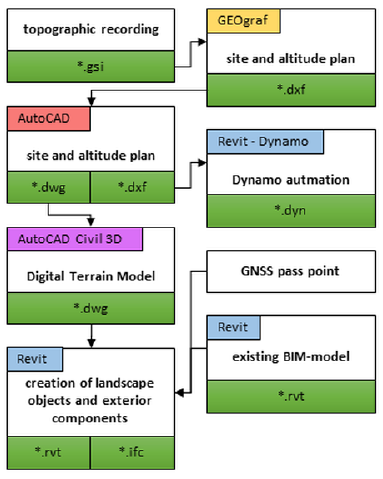
Figure 2 Workflow including used software and exchange formats